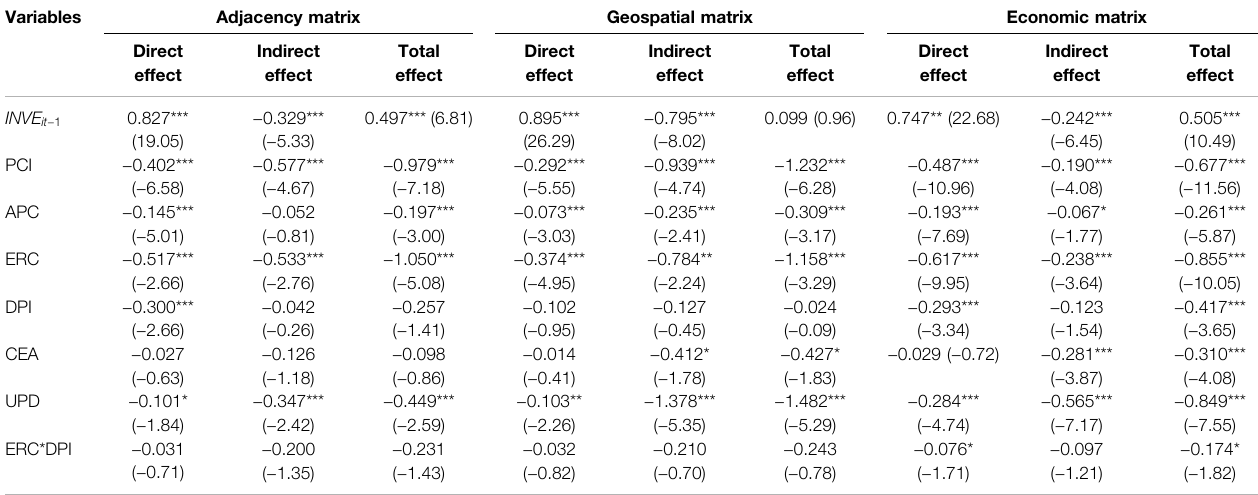
TABLE 6 | Decomposition of the random effects SDM